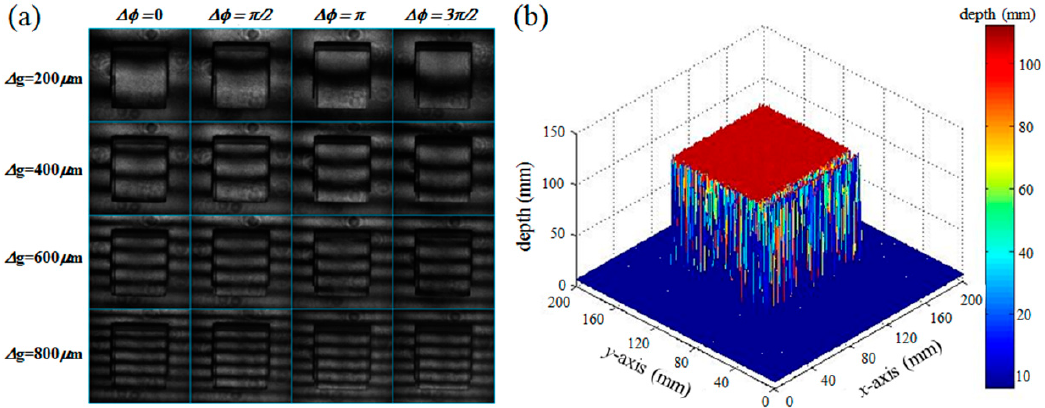
Figure 14. ( a ) CCD images of the distorted fringe patterns projected on the square box object; ( b ) 3D depth profile reconstructed from the square box object.